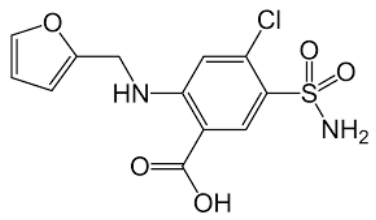
l. Diuretics: Furosemide (Figure 12), Hydrochlorothiazide (Figure 13) and its metabolite